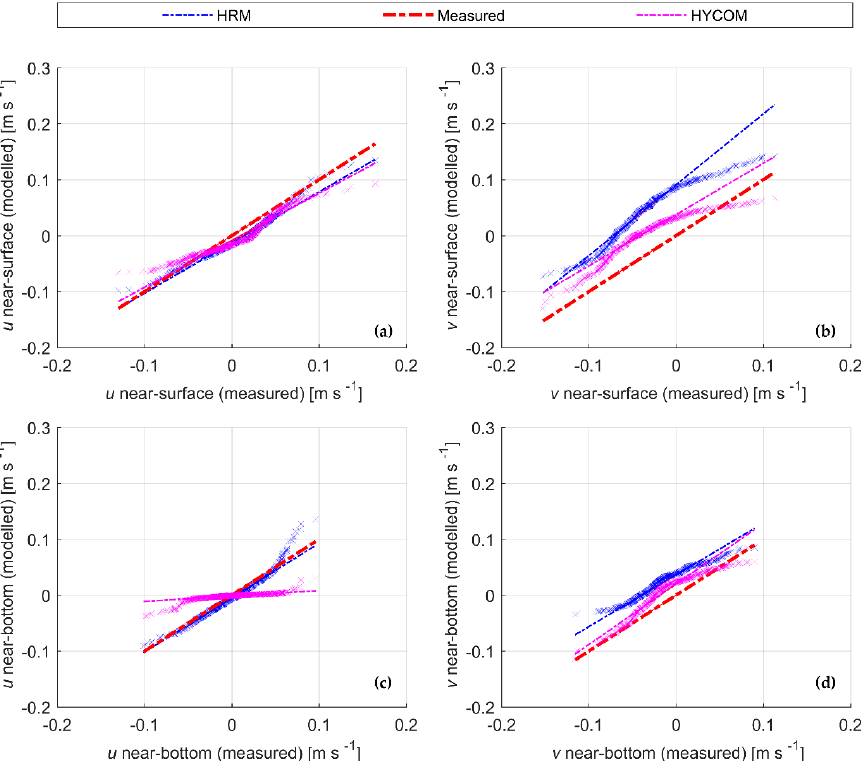
Figure 5. Quantile-quantile plot of near-surface ( a , b ) and near-bottom ( c , d ) velocity components at CU4, near Gordon’s Bay.